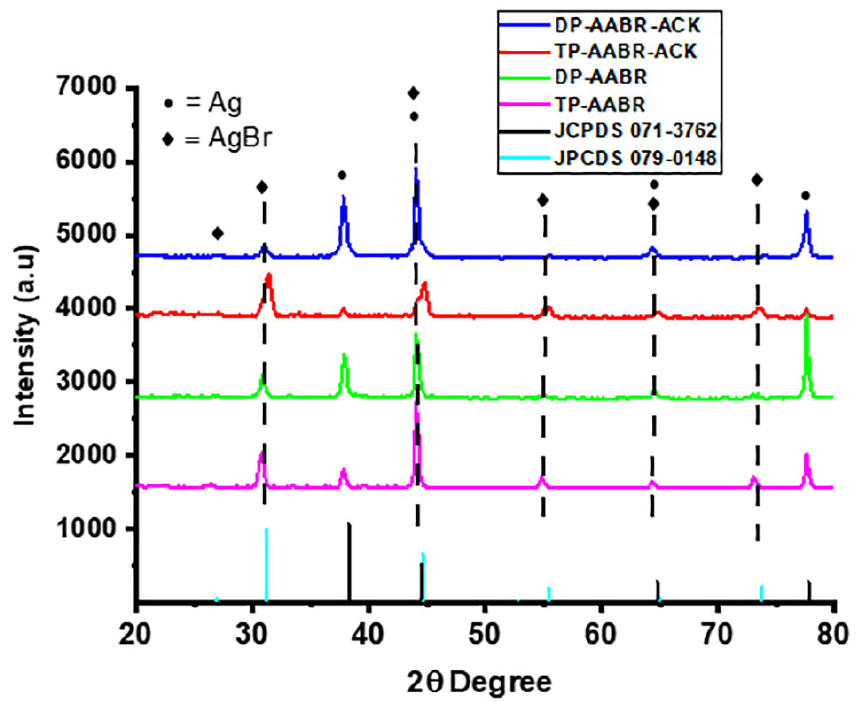
Figure 1. XRD patterns of DP-AABR-ACK, TP-AABR-ACK nanocomposites, DP-AABR, and